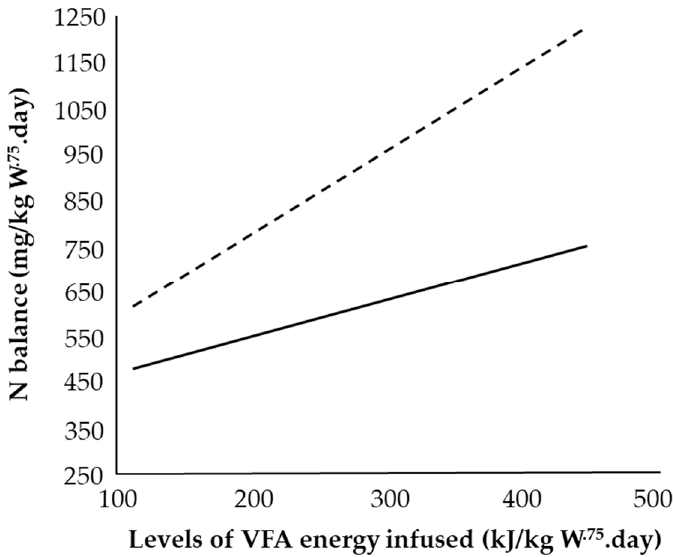
Figure 5. Mean N balance of heavy (solid line, n = 2) and light (dashed line, n = 3) sheep with incremental volatile fatty acids (VFA) infusion and a fixed infusion of 2250 mg casein-N/kg W .75 .day. Heavy = 61 ± SD 2.2 kg liveweight. Light = 39 ± SD 4.5 kg liveweight. Adapted with permission from [59].